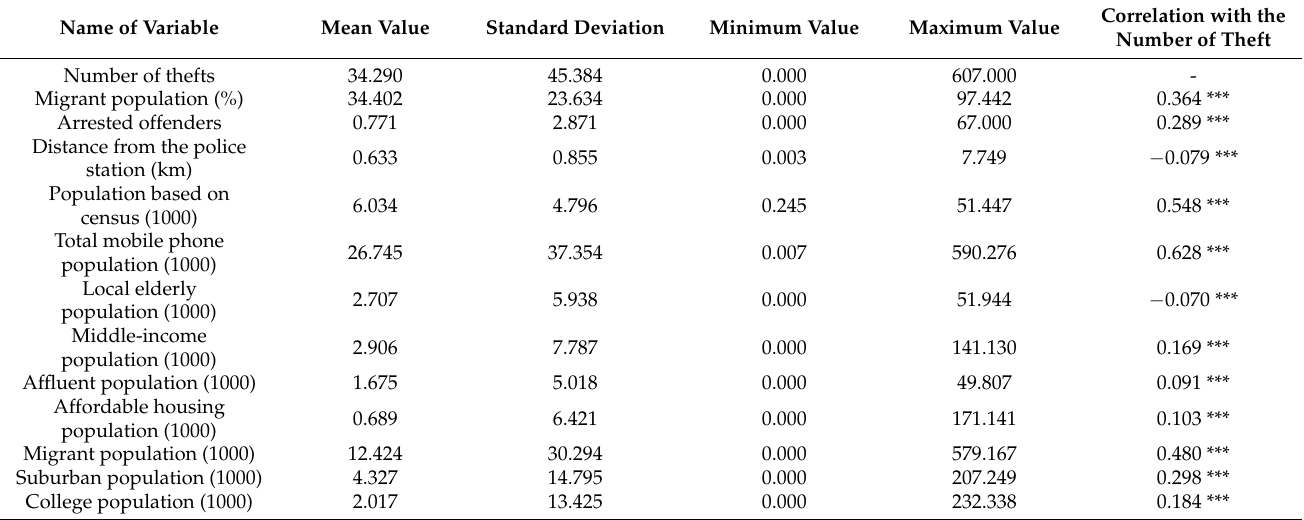
Table 3. Descriptive statistics of